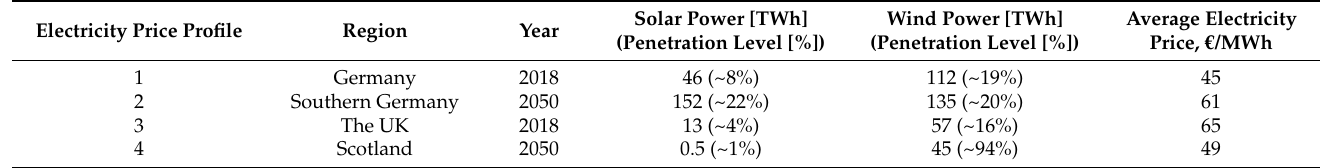
Table 2. The four electricity price profiles used as inputs to the steel process